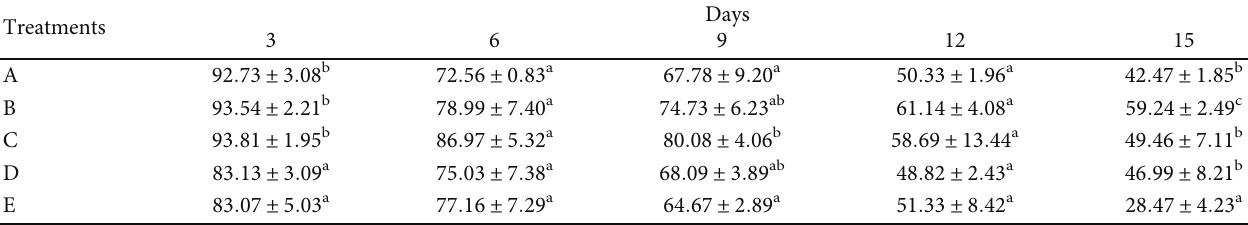
Data are presented as means ± SD ( n = 3 ). For a given sampling event, di ff erent superscript letters above bars indicate signi fi cant di ff erences among